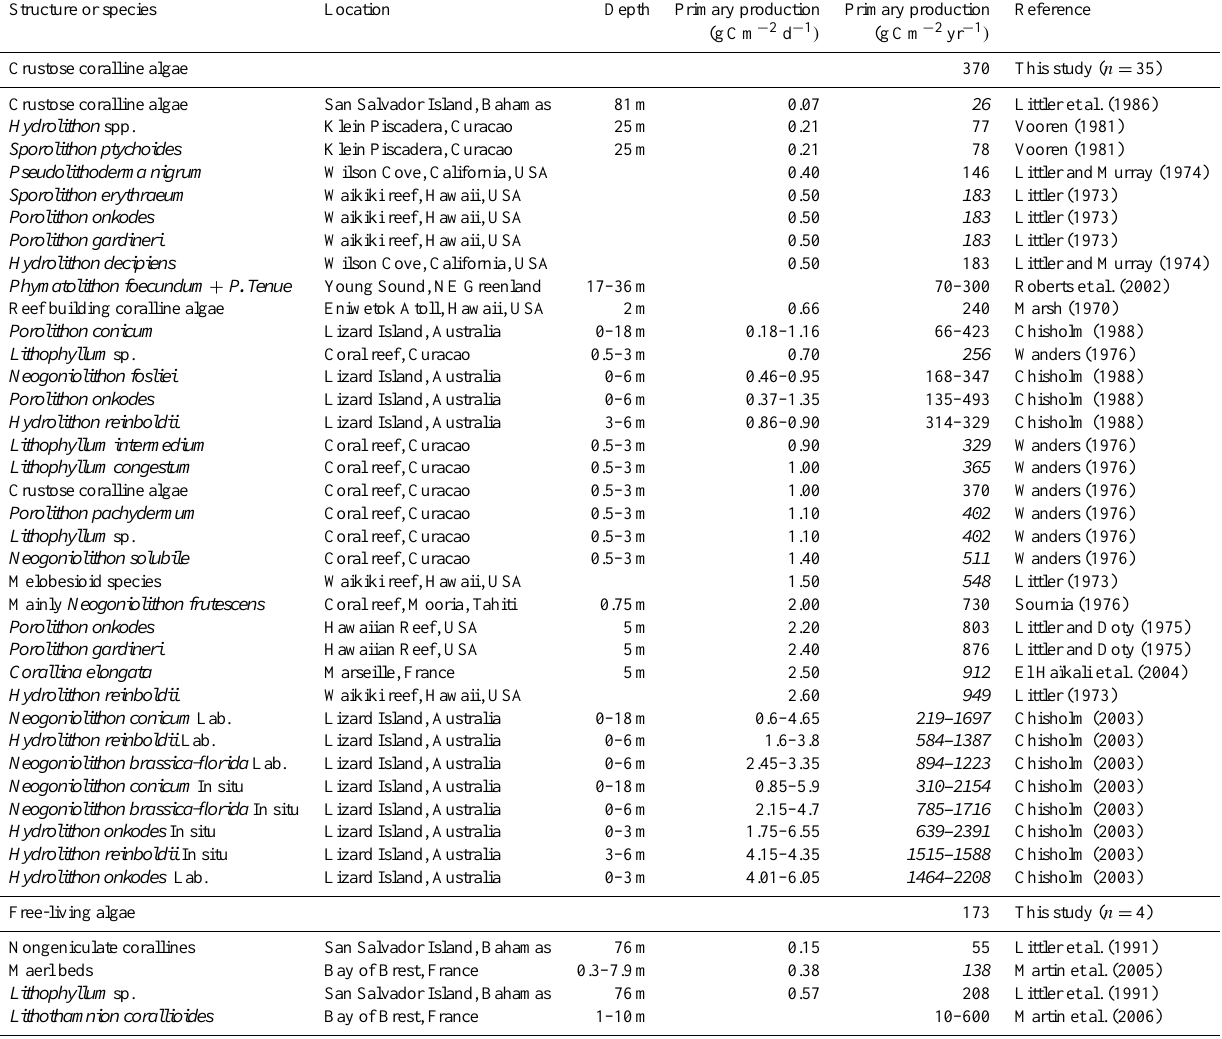
Table 1. Net primary production (daily and annual) of coralline algae (communities) from different depths and locations. Yearly primary production indicated in italics are an estimate of the yearly production by taking a daily production and modifying this to a yearly production ( × 365). The median production for crustose coralline algae and free-living algae is indicated. Structure or